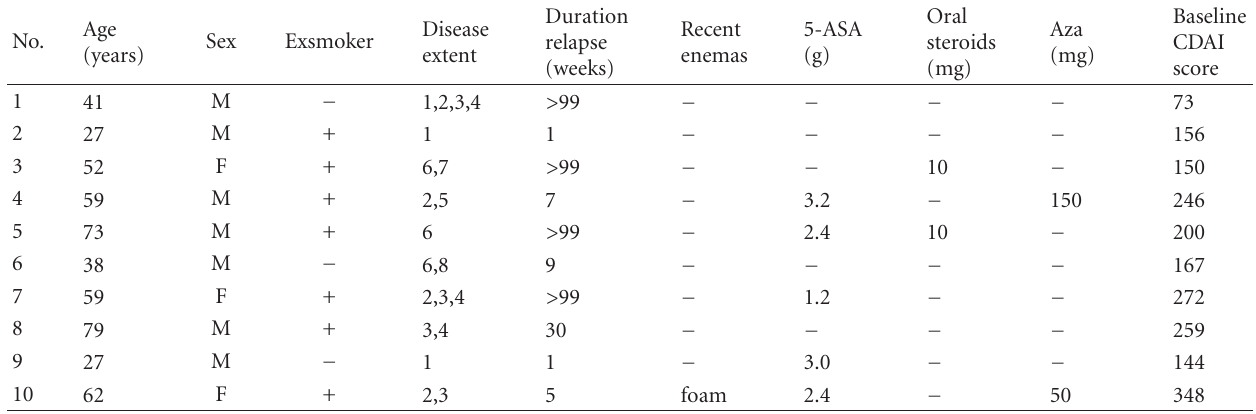
Table 2: Baseline characteristics of 10 patients with Crohn’s colitis. Extent of disease: 1 = proctitis, 2 = sigmoid colon, 3 = descending colon, 4 = transverse colon, 5 = ascending colon, 6 = pancolitis, 7 = ileal, 8 = perianal. “Recent enemas” refers to any steroid or 5 aminosalicylate (5-ASA) enemas taken from 1 to 3 weeks before entry into the study. All concomitant medication doses given are the daily amounts, the only